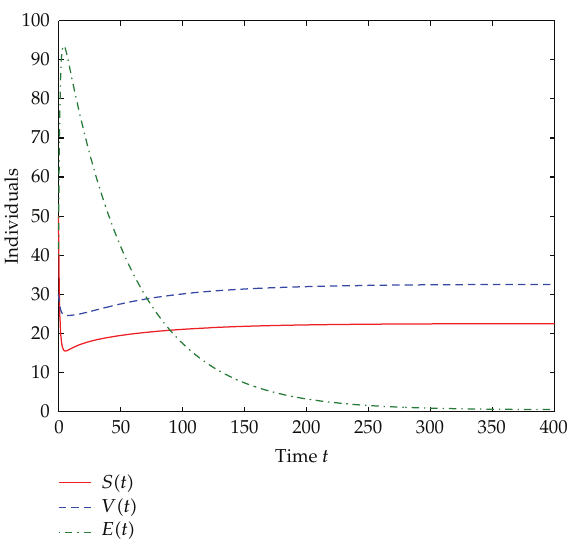
Figure 2: When R 0 < 1, the disease-free equilibrium P 0 is globally asymptotically stable.